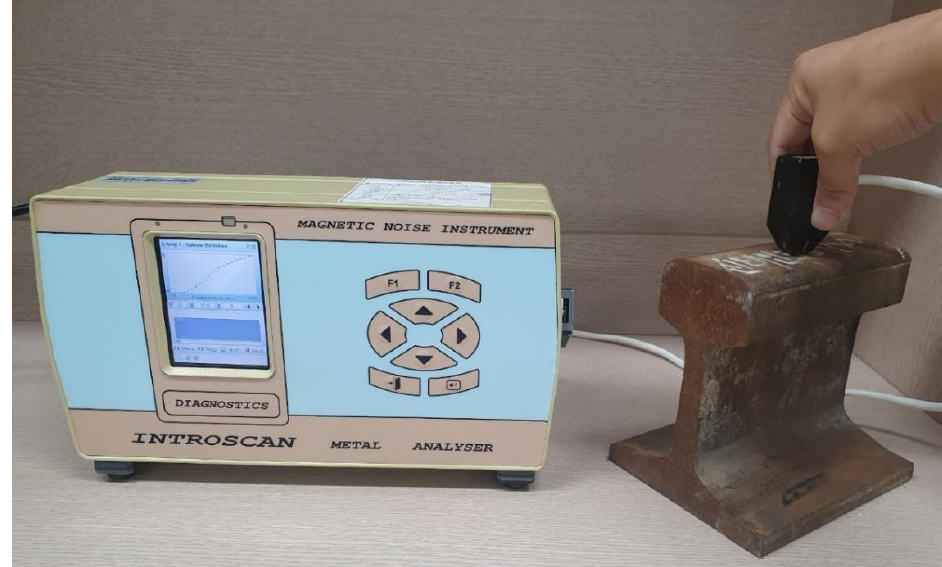
Figure 5. Photograph of the experimental setup for measuring residual stresses in the used rails.